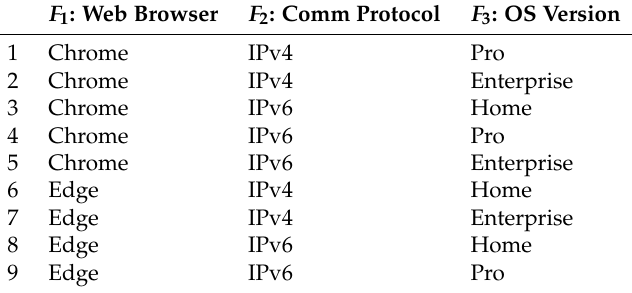
Table 2. Test sets corresponding to locating arrays (LAs).